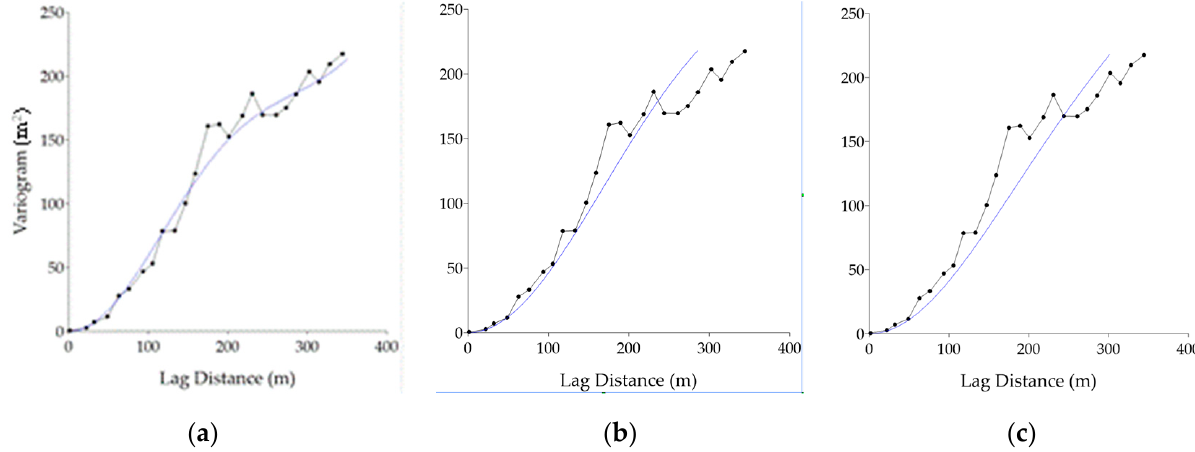
Figure A2. Theoretical variogram (blue line) calibrated by fitting the empirical variogram (black line with dots): ( a ) power and wave (hole effect) components, ( b ) Gaussian model and ( c ) rational quadratic model. Table A3. Statistics of the residual errors of the tested variogram components.